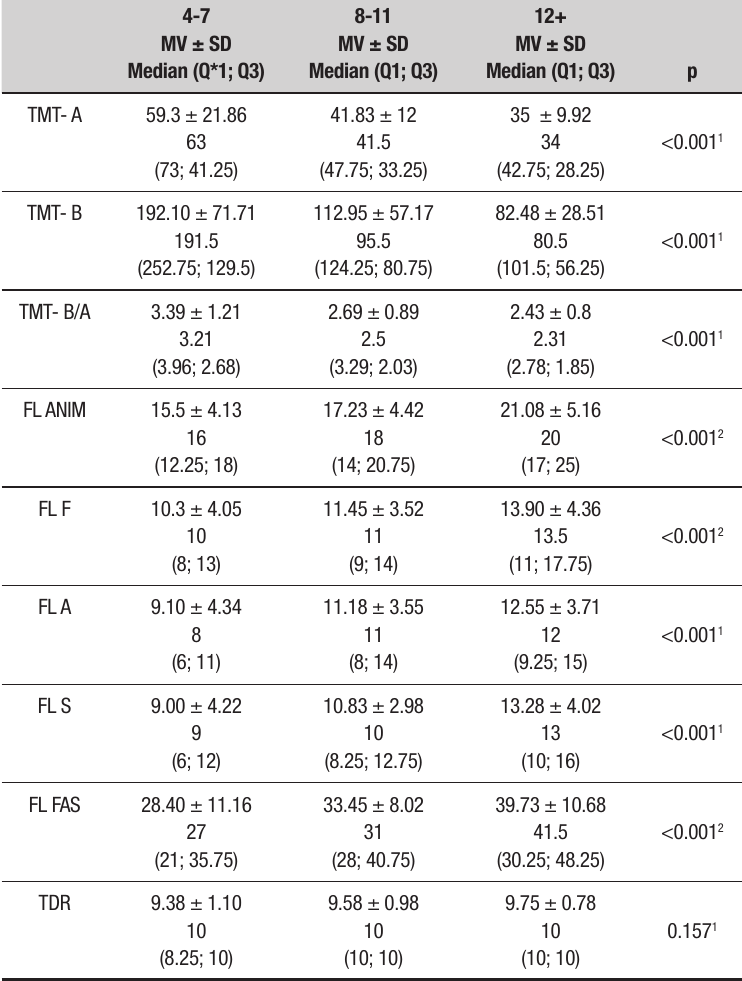
Table 4. Comparisons of groups by educational